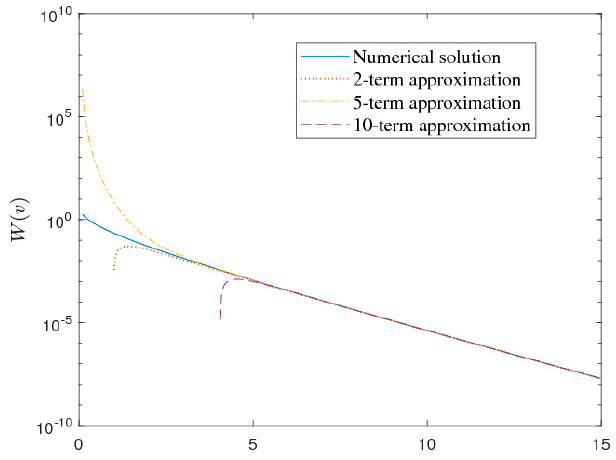
Figure 2. Comparison between numerical solution and 10, 20, and 40 terms of the series Equation (35) for W ( v ) .